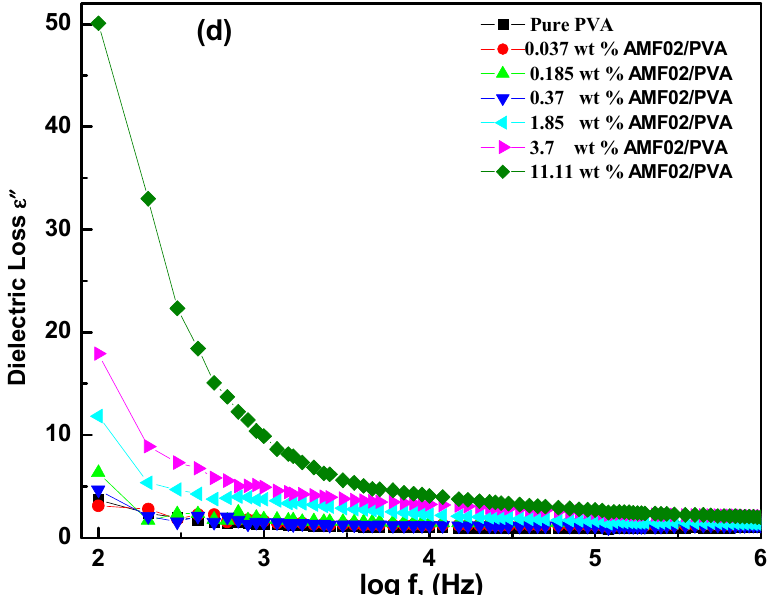
Figure 10. ( a ) Real, ( b ) dielectric permittivity of PVA vs. wt% of AMF02 at fixed frequencies, ( c ) loss tangent (tan δ ), and ( d ) imaginary parts of dielectric permittivity against frequency for all novel PCCEFs.